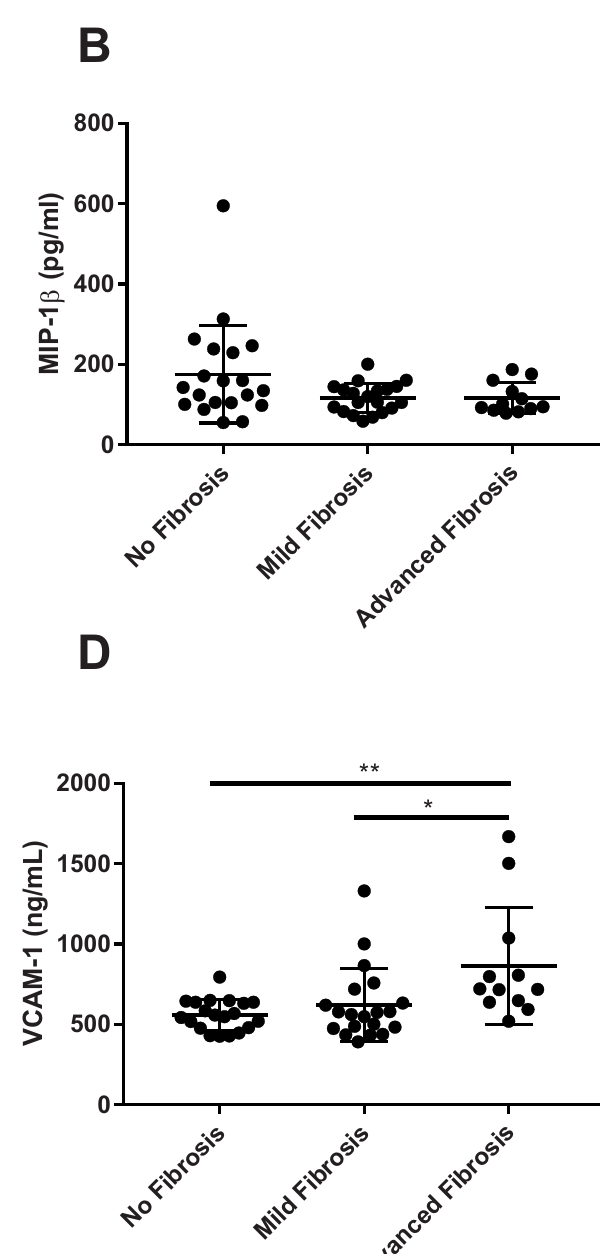
PLOS ONE | https://doi.org/10.1371/journal.pone.0217263 July 10,